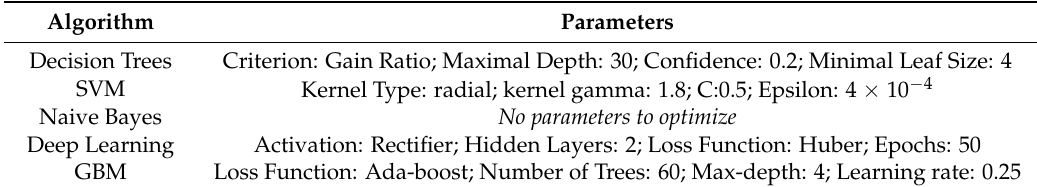
Table 10. Parameter values, upon completion of the parameter tuning process for Experiment D.